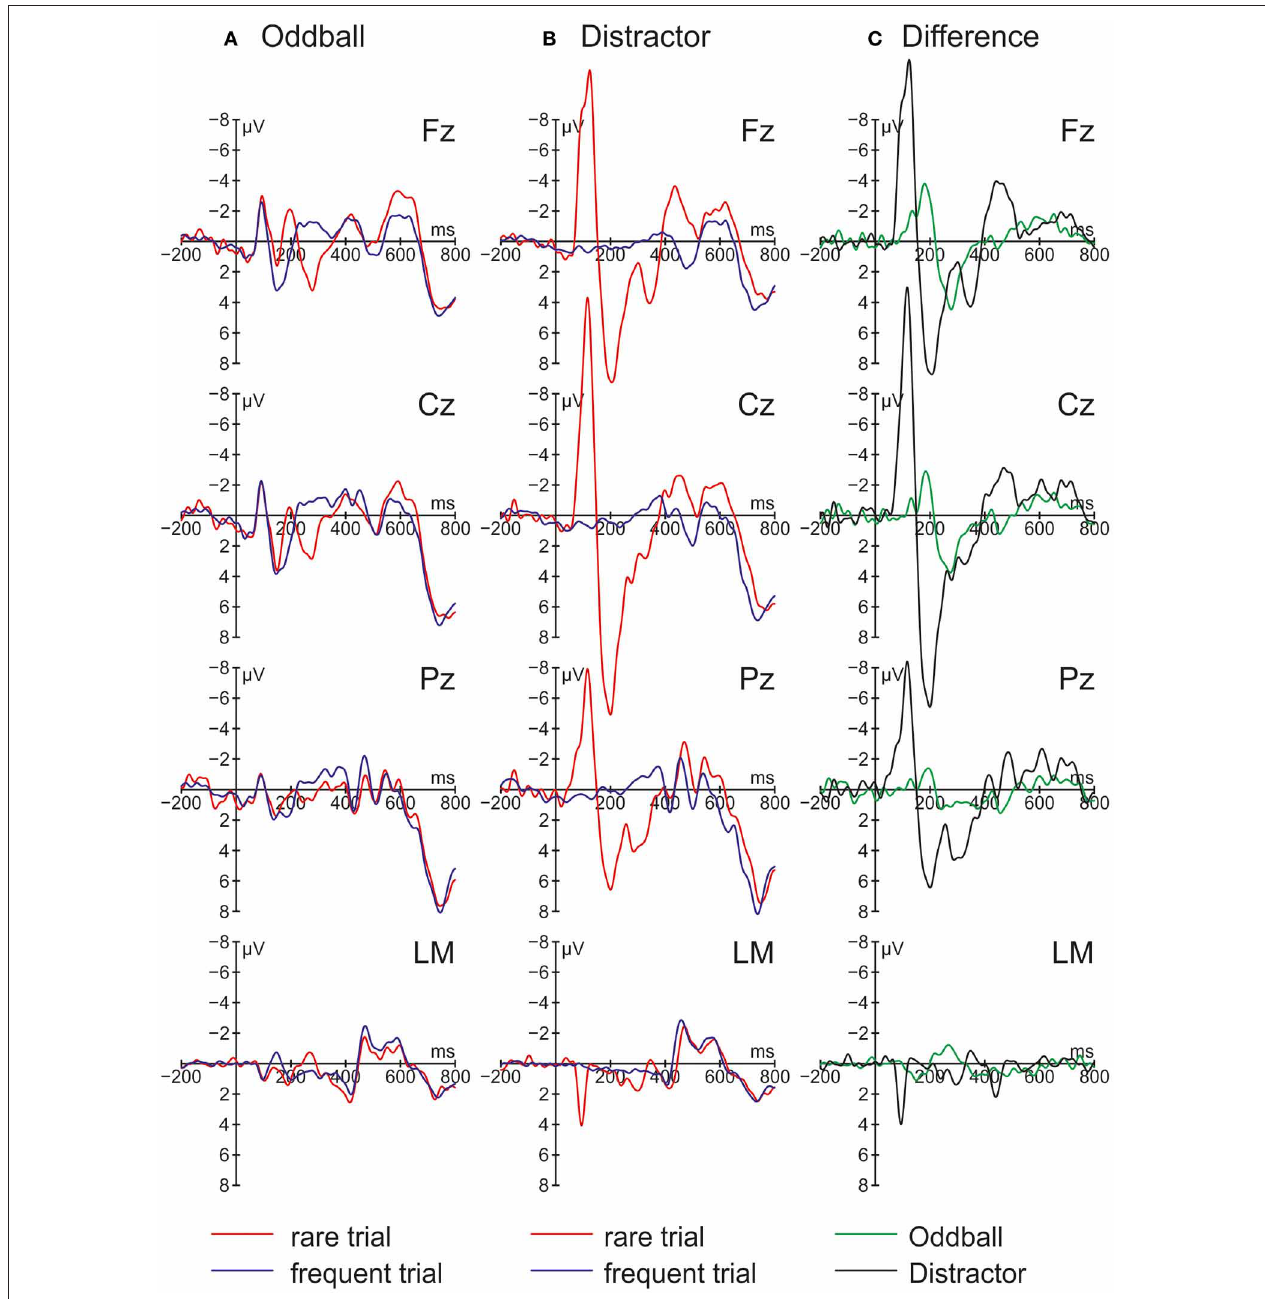
FIGURE 2 | Grand average event-related brain potentials (ERPs) and difference waves obtained in Experiment 1 ( N = 10). ERPs are depicted separately for rare and frequent trials in (A) the Oddball